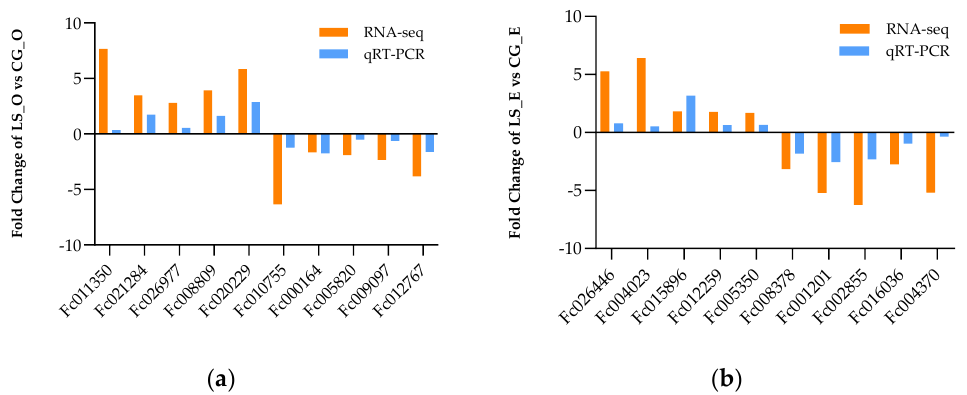
Figure 8. The results were verified by qRT – PCR. ( a ) Relative fold change of DEGs between qRT – PCR and RNA – seq results in LS _ O vs. CG _ O group; ( b ) relative fold change of DEGs between qRT – PCR and RNA – seq results in LS _ E vs. CG _ E group. Relative expression levels from the RNA – seq results were calculated as log 2 FC values: Fc011350 ecdysteroid regulated; Fc021284